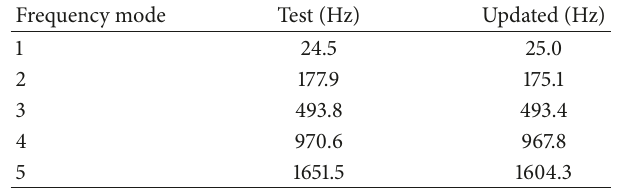
Table 4: Comparison of natural frequencies.